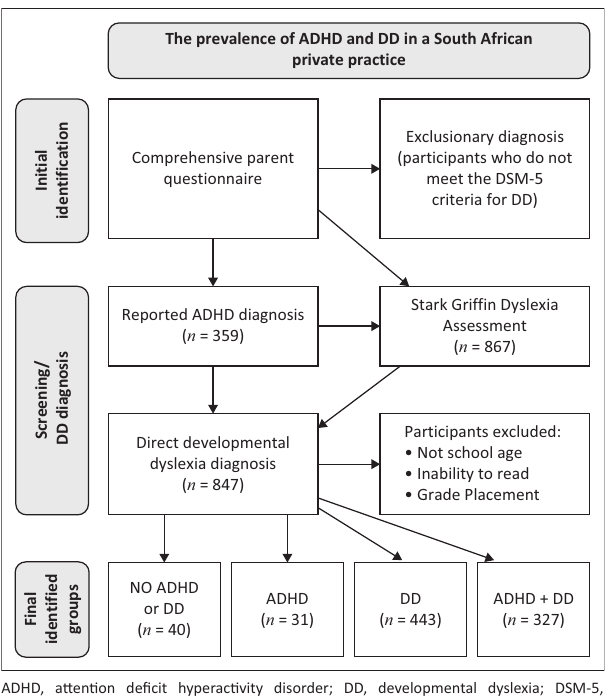
FIGURE 1: Methodology flow chart of data collected for 4 groups related to attention deficit hyperactivity disorder and/or developmental dyslexia diagnosis for the study of prevalence of these disorders in a South African